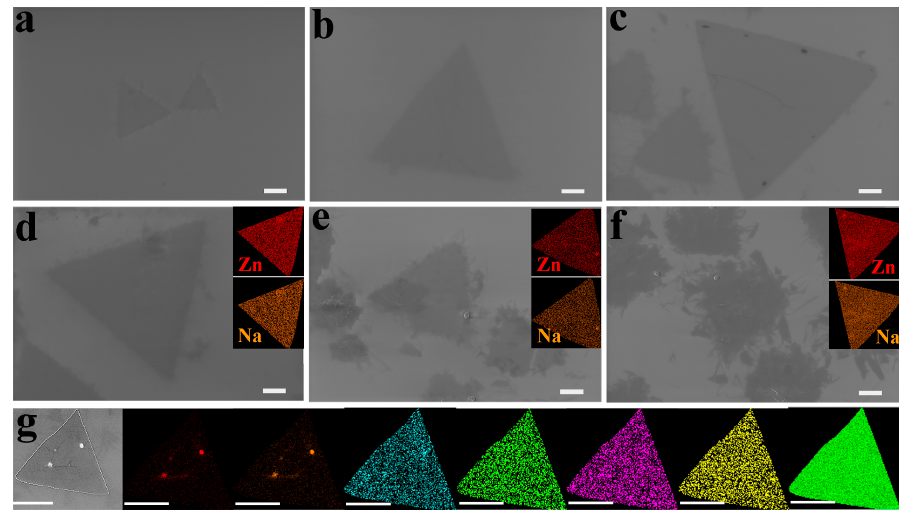
Figure 1. Controlling the growth of 2D ZnO by the amount of surfactant. SEM images of 2D ZnO synthesized with the ratio of sodium oleyl sulfate to Zn 2+ is around ( a ) 6 × 10 − 5 , ( b ) 8 × 10 − 5 , ( c ) 10 × 10 − 5 , ( d – f ) 11 × 10 − 5 , 13 × 10 − 5 , and 14 × 10 − 5 . Insets are the corresponding EDS mapping images of Zn and Na elements. Scale bar is 1 μ m. ( g ) SEM image and EDS mapping images for Zn, Na, C, Cl, N, S, and O elements, respectively. Scale bar is 2.5 μ m.